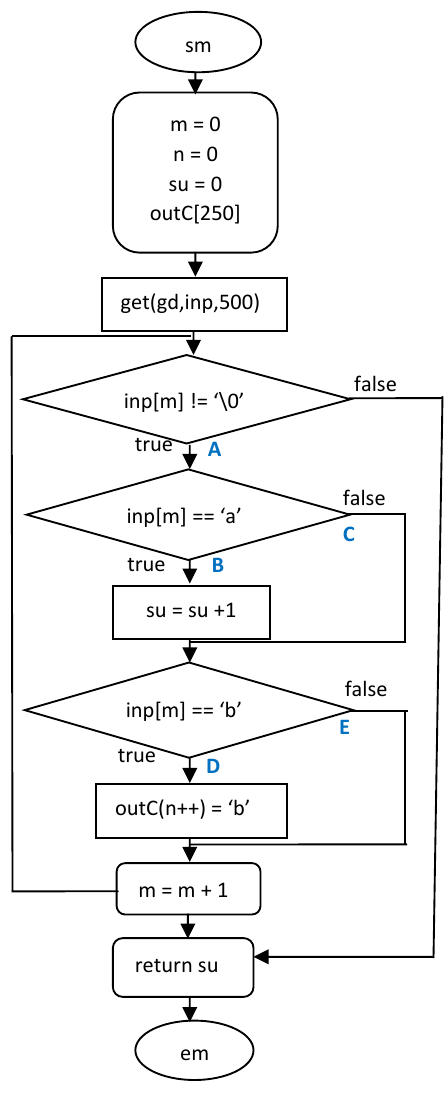
Fig. 1 : Example program for buffer overrun